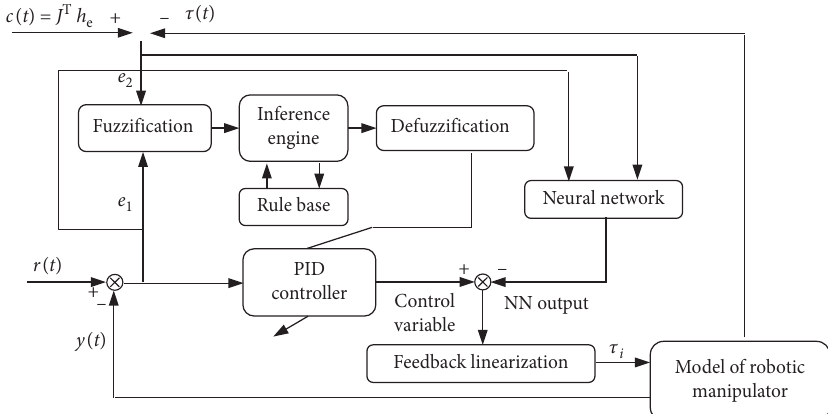
Figure 3: Block diagram of the proposed fuzzy PID with